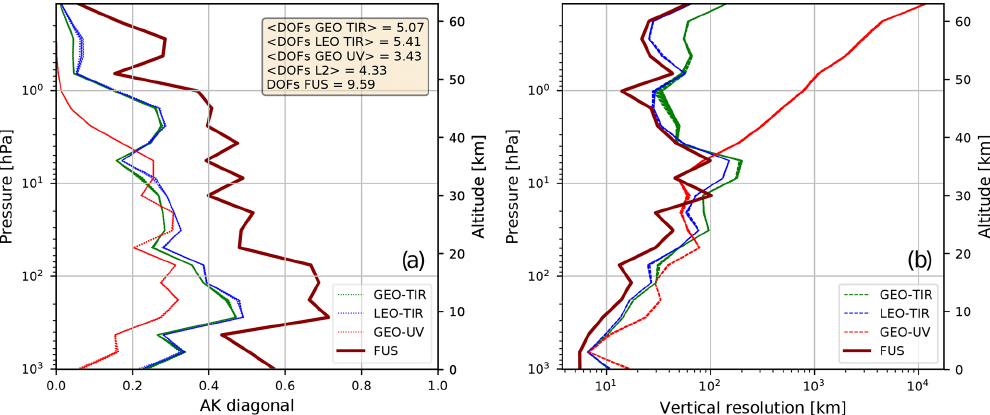
Figure 3. (a) AK diagonals for the GEO-TIR products (red lines), LEO-TIR products (blue lines), GEO-UV products (red lines) and the FUS product (dark red line). In the text box, the average number of DOF for each type of L2 product, the average number of DOF for all L2 products and the number of DOF of the FUS product are reported. (b) Vertical resolution (FWHM) profiles for the GEO-TIR products (red lines), LEO-TIR products (blue lines), GEO-UV products (red lines) and the FUS product (dark red line). In each panel, while the solid dark red line is a single one, the red and green lines are both 55 overlapped lines, and the blue lines are eight overlapped lines (one for each L2